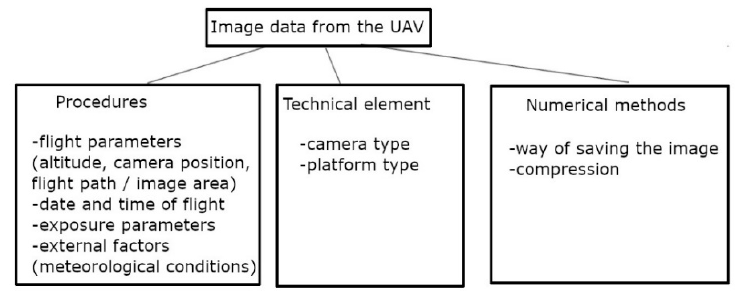
Figure 1. A breakdown of factors influencing UAV image quality (based on [9]).